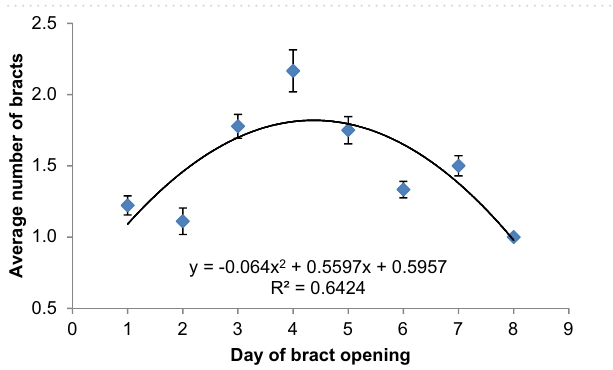
y = -0.064x 2 + 0.5597x + 0.5957 R² = 0.6424